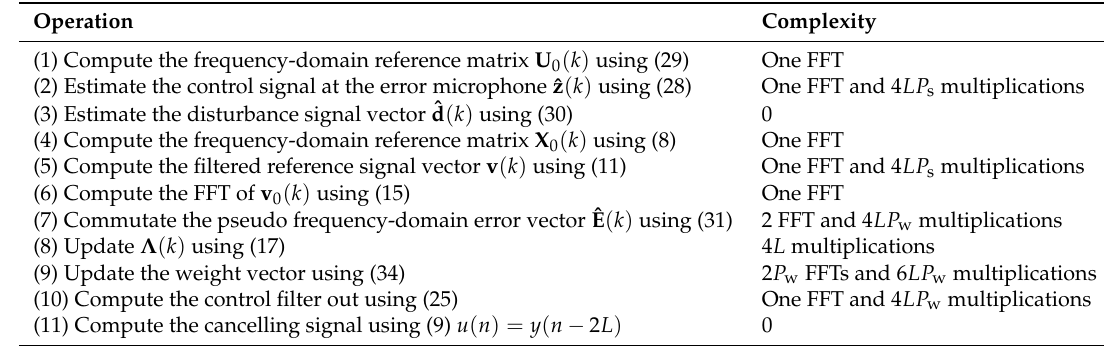
Table 5. FPBMFxLMS algorithm